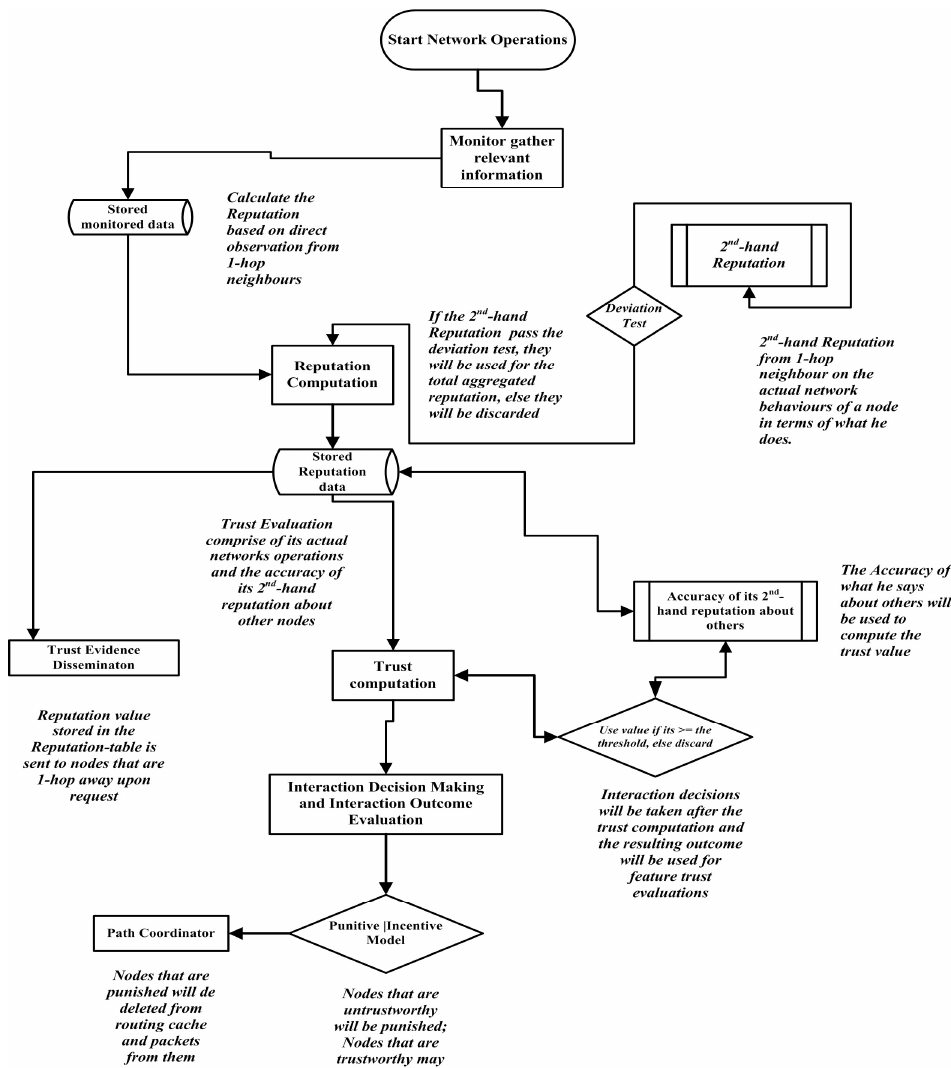
Figure 4. The flow chart for the Dirichlet Reputation and Trust Computation in the TRM Model.